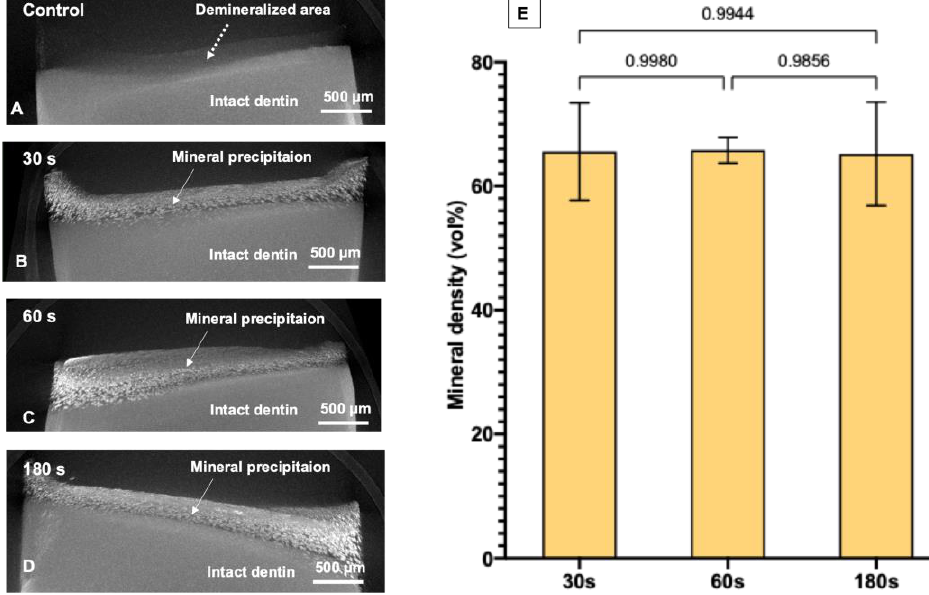
Figure 6. Reconstructed SRXTM images of a representative specimen from each group after immersion in simulated body fluid for 2 weeks. ( A ) The control group showed a demineralized area (~250 μm depth, dashed arrow) without evident mineral precipitation. ( B – D ) Reconstructed images from the representative specimen from 30, 60, and 180 s groups, respectively. The images show substantial mineral precipitation in the demineralized area (solid arrows). ( E ) Mean mineral density obtained from 30, 60, and 180 s groups. Error bars are 95% CI (n = 6). Lines indicate p > 0.05. Data from the control group were not analyzed because mineral precipitation was not detected. The 3D visualization images of the specimens are provided in the Supplementary Materials (S1, S2).